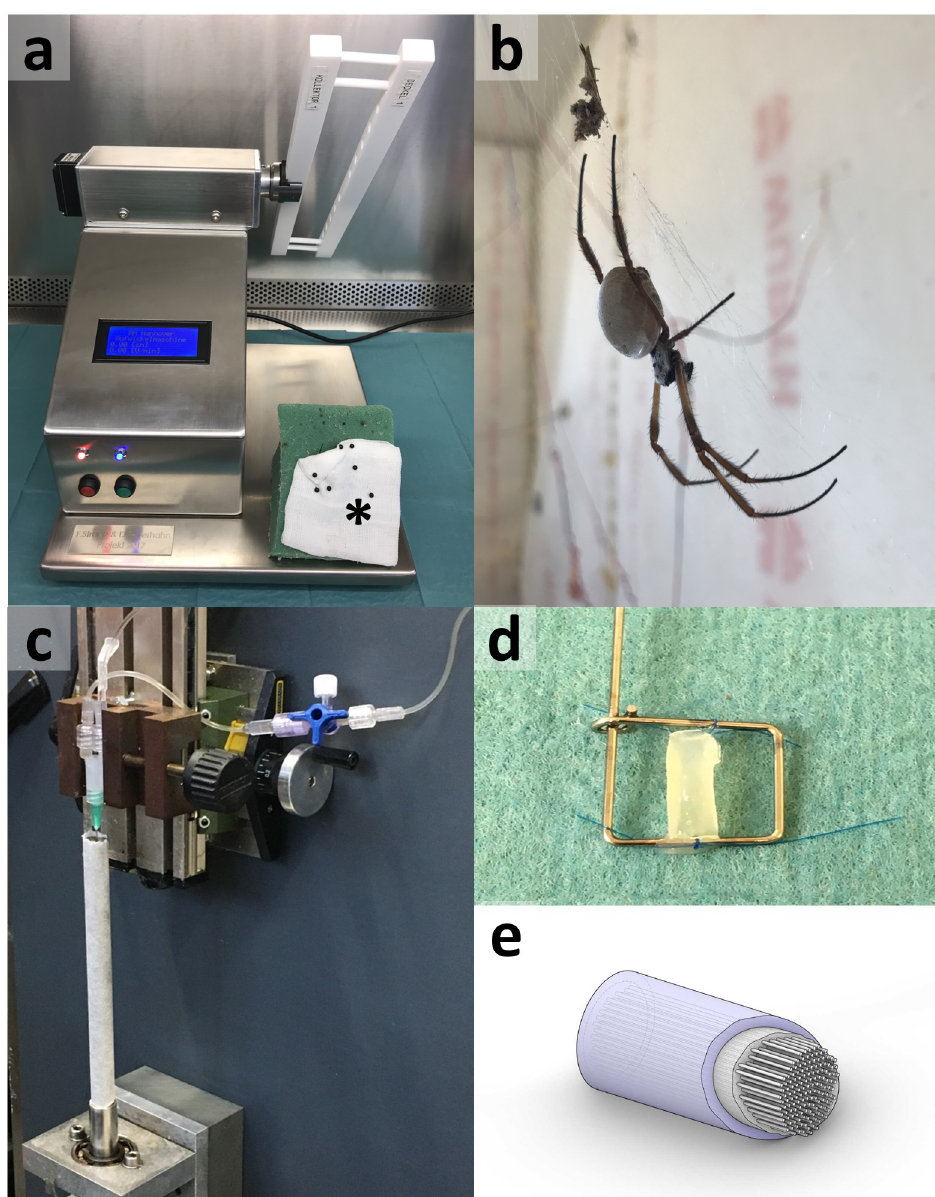
Fig 1. Construct fabrication. A: computerized reeling machine for spider silk harvest [30]. The spider is carefully fixed underneath a compress with needles placed between the spiders’ legs and in front of the head, indicated by a star. B shows a female Nephila edulis spider in the department’s animal facility. In c, the apparatus for fibrin manufacturing can be seen. D shows the fibrin sheath containing spider silk (reeled between the metal frame). E is a scheme of the implant. It shows the dense fibrin tube containing the longitudinally orientated spider silk which is held in position by a fibrin filling.